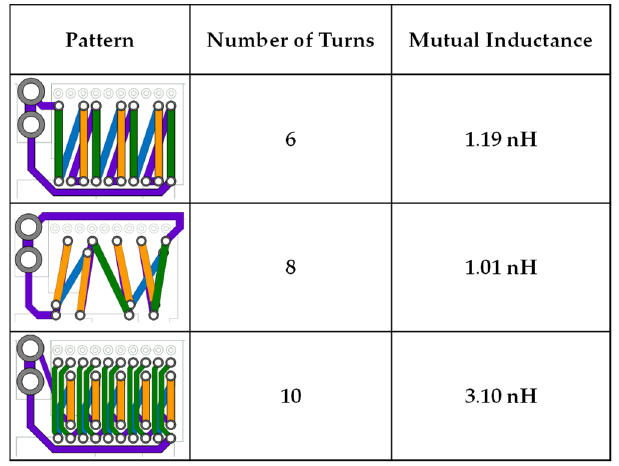
Figure 8. Physical structure of the PCB pick-up coil and the parameters.